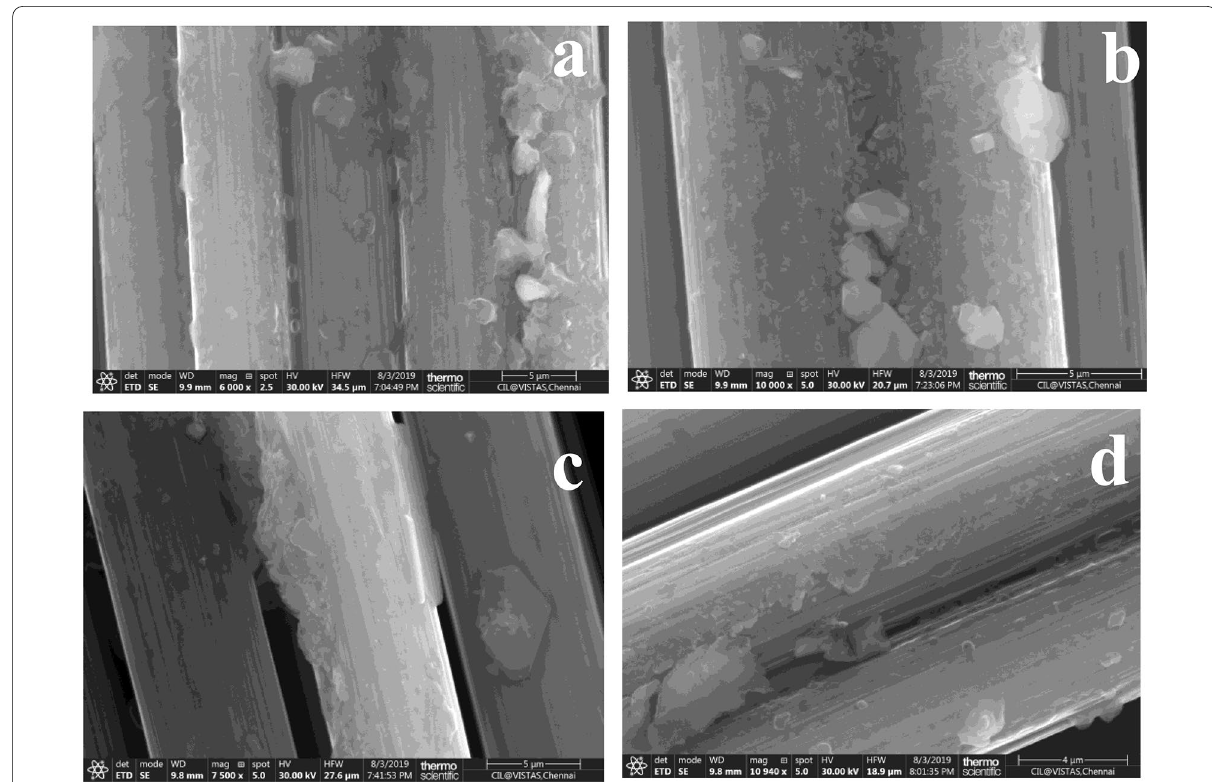
Fig. 3 FESEM images of PMB film with coated CFF using a 0.1 mM MB, b 0.2 mM MB c 0.4 mM MB and d 1.0 mM MB